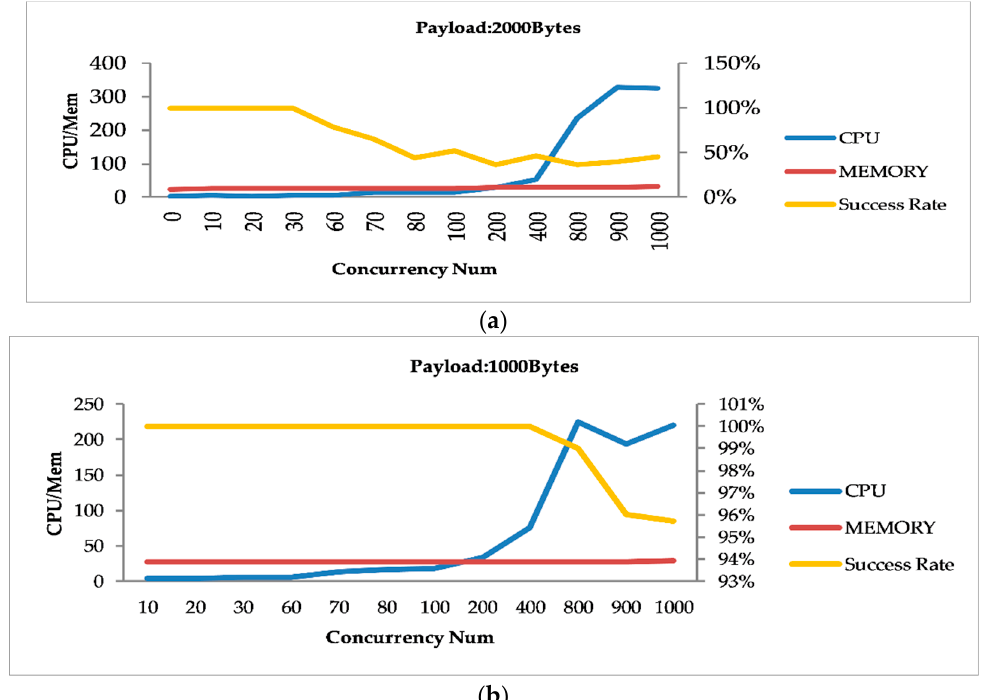
Figure 11. System performance under different loads: ( a ) a payload of 2000 bytes; and ( b ) a payload of 1000 bytes.